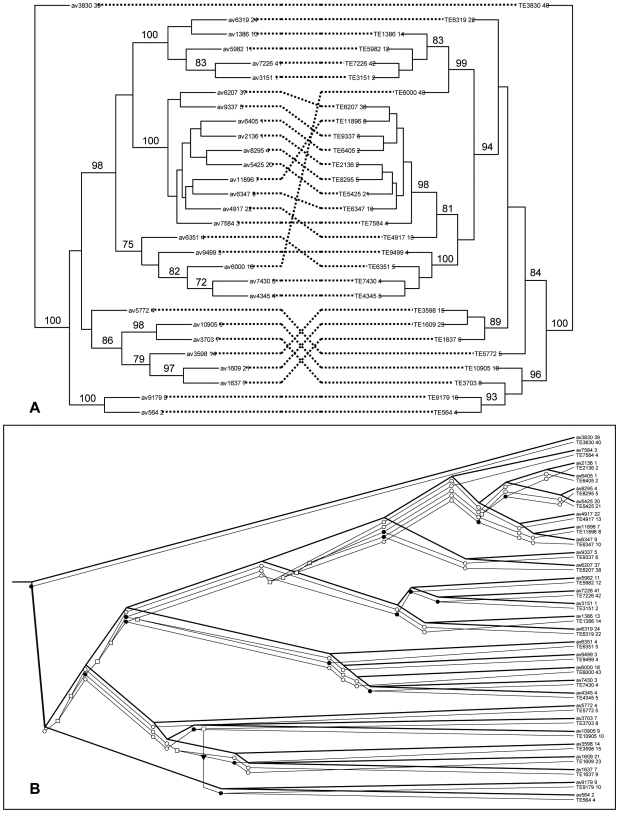
Comparison of the phylogenies of AVR
k1 and TE1a sequences.A. Tanglegram for AVR
k1 (left) and TE1a (right) sequences, based on predicted ORFs from Bgh genome. Lines connecting sequences indicate associations. Bootstrap support (1,000 replicates) is shown below the branch if higher than 70%. B. One of the four potentially optimal reconciled trees between AVR
k1 and TE1a trees. The two trees are superimposed. Hypothetical evolutionary events are represented as black circles for codivergence events, white squares for duplication events, white circles for gene losses and arrows for gene transfers.